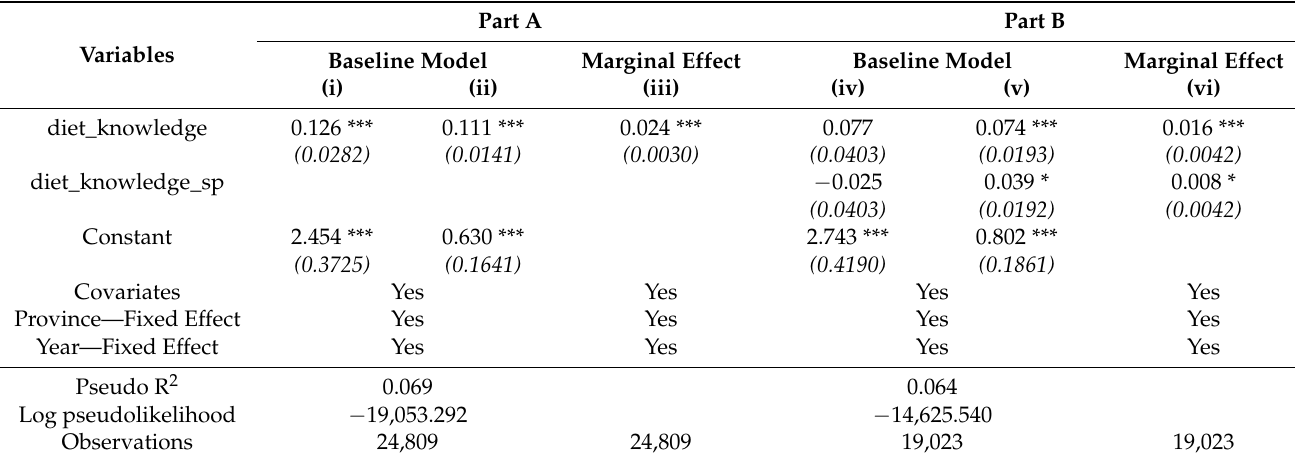
Table A3. Robustness check of the effect of dietary knowledge on health II (changing the sample).